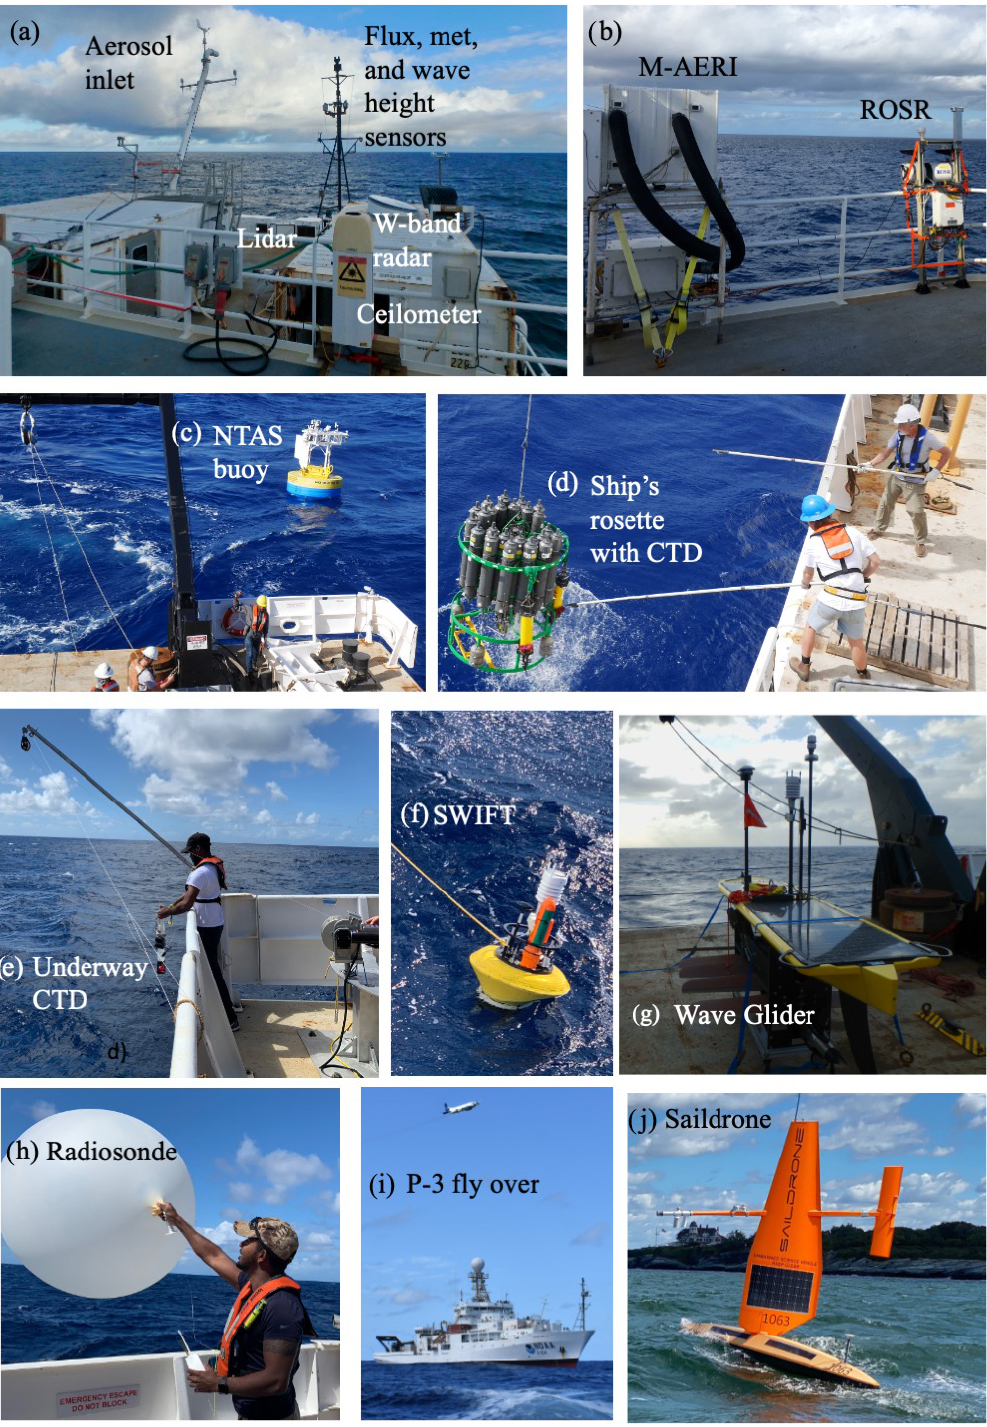
Figure 3. Instrumentation on board the RV Ronald. H. Brown for the measurement of atmospheric and oceanic parameters located on (a) the bow mast and forward O2 deck and (b) port side O3 deck. Asset deployments are shown for (c) NTAS mooring, (d) ship’s rosette with CTD and Niskin bottles, (e) uCTD, (f) SWIFT, (g) Wave Glider, and (h) radiosonde. Also shown are (i) P-3 fly over of the ship on 23 January and (j) Saildrone upon its return to the United States (Newport, RI) from Barbados. Not shown are disdrometers on the port O3 deck and camera on the starboard O3